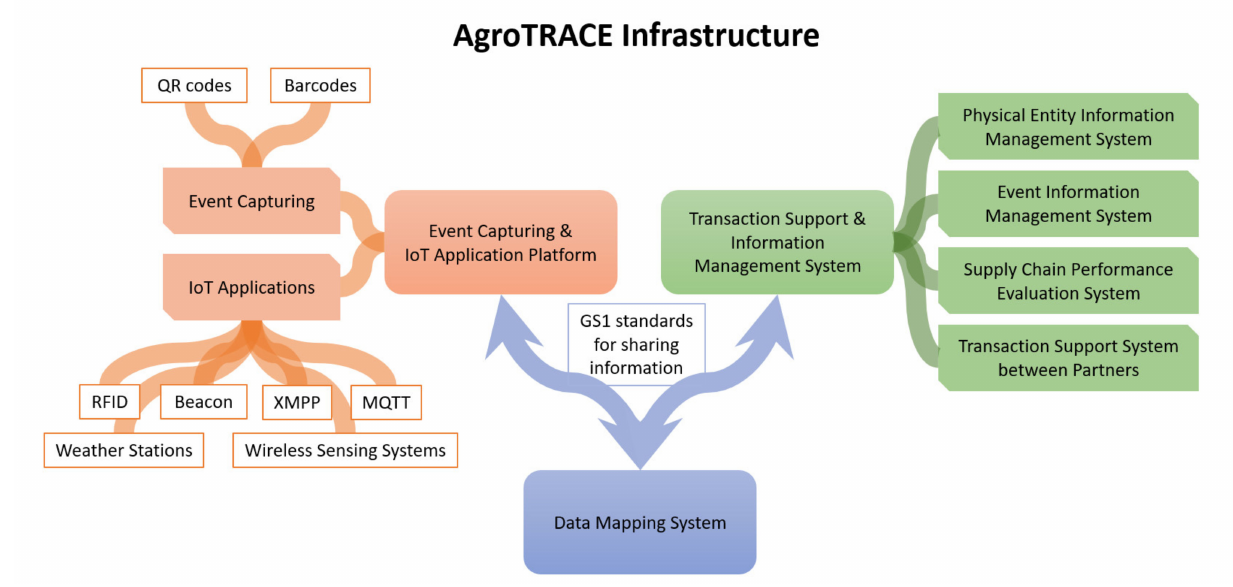
Figure 3. Simplified graph of the infrastructure of AgroTRACE system showing its main three elements and the involved